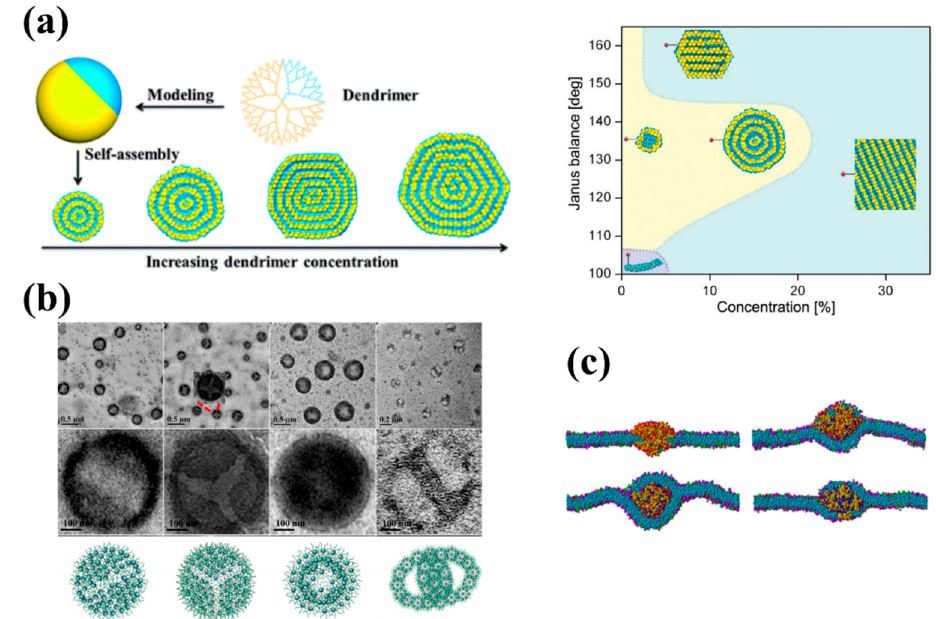
Figure 4. ( a ) Schematic of self-assembly of nanoarchitectures from Janus dendrimers and the corresponding structure–concentration phase diagram for amphiphilic dendrimer aqueous solutions [150]. ( b ) Self-assembled morphologies by various C a -POSS b -PEG c polymers observed by microscopy ( top , with zoom-in on nanoscopic feature in the middle panel) and corresponding DPD modelling images of self-assemblies by the amphiphilic polymers at the initial polymer concentration of 1 mg/mL in aqueous solutions ( bottom ) [153]. ( c ) Typical calculated states of the interactions between a lipid bilayer membrane and a PAMAM dendrimer conjugated with ligands. The receptor density of the membrane is fixed at f R = 0.33. The surface tension of the membrane, σ , and the ligand density of the dendrimer, f L , are ( top left ) σ = 2.09 k B T/r c2 and f L = 0.1, ( top right ) σ = 0.10 k B T/r c2 and f L = 0.4, ( bottom left ) σ = − 0.65 k B T/r c2 and f L = 0.6, and ( bottom right ) σ = 1.10 k B T/r c2 and f L = 0.8. Color scheme: lipid head beads (pink), lipid tail beads (cyan), receptor beads (green), charged beads of dendrimer (red), uncharged beads of dendrimer (yellow), and ligand beads (blue) [156].